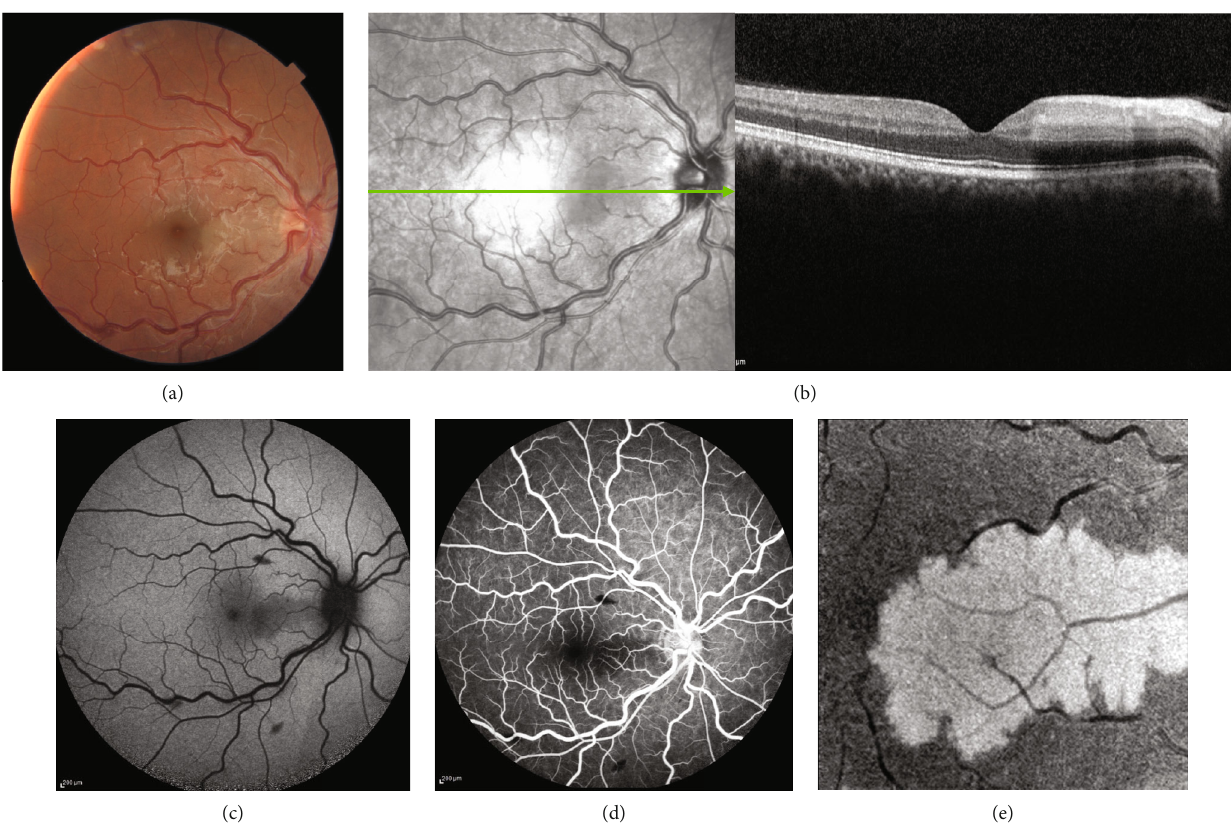
Figure 1: (a) The fundus photograph of the right eye shows disc swelling, multiple dot-like retinal hemorrhages, venous tortuosity, and a gray-white opacity in the papillomacular bundle. (b) Spectral-domain optical coherence tomography illustrates a hyperre fl ective band in the level of INL, and in infrared re fl ectance image, a grayish lesion with sharp borders in the papillomacular bundle can be observed. (c) Fundus auto fl uorescence shows the lesion as a hypoauto fl uorescence lesion. (d) The late phase of fl uorescein angiography (3 ′ :1 ″ ) discloses no signi fi cant nonperfusion area. (e) 3 ∗ 3 mm en face optical coherence tomography angiography image of the right eye lesion revealed edema in the level of deep capillary